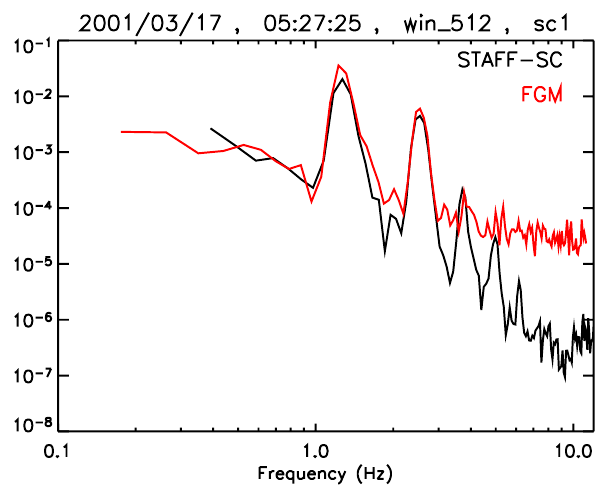
Fig. 2. Total power of magnetic field fluctuations observed by Clus- ter FGM (red) and STAFF (black) instrument on-board of space- craft 1 centered at 05:27:25 UT (2 × 256 data points are